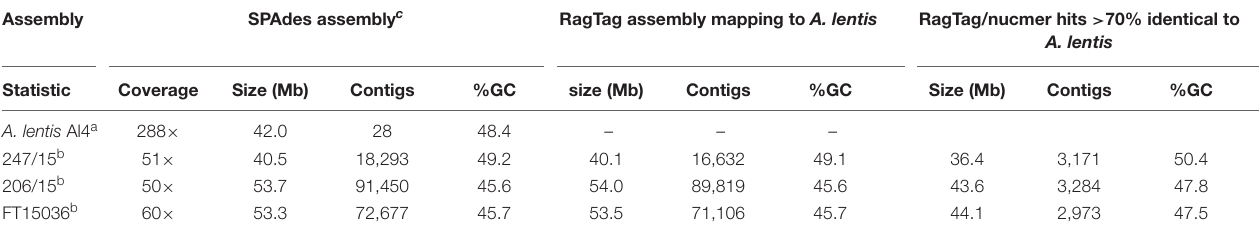
TABLE 3 | Ascochyta fabae genome sequencing. Sequencing and assembly statistics for A. fabae genomes and RagTag assemblies scaffolded on the A. lentis Al4 reference genome. Assembly SPAdes assembly